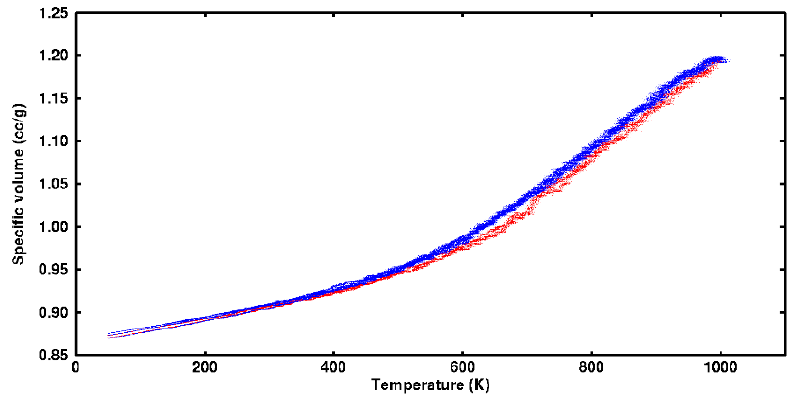
Figure 10. Specific volume as a function of temperature for the short-chain stoichiometric system. Data points for five cycles of heating and cooling are blue and red, respectively.